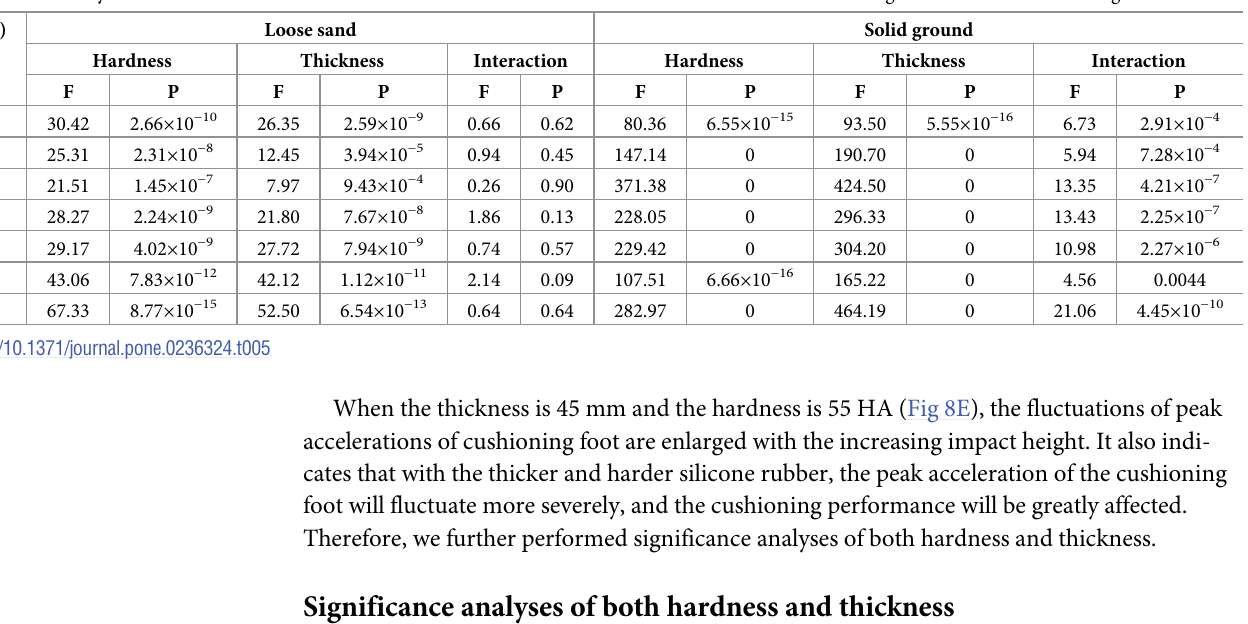
Table 5. Significant analyses of both hardness and thickness. F and P values of both hardness and thickness at different heights on loose sand and solid ground. Height (cm)